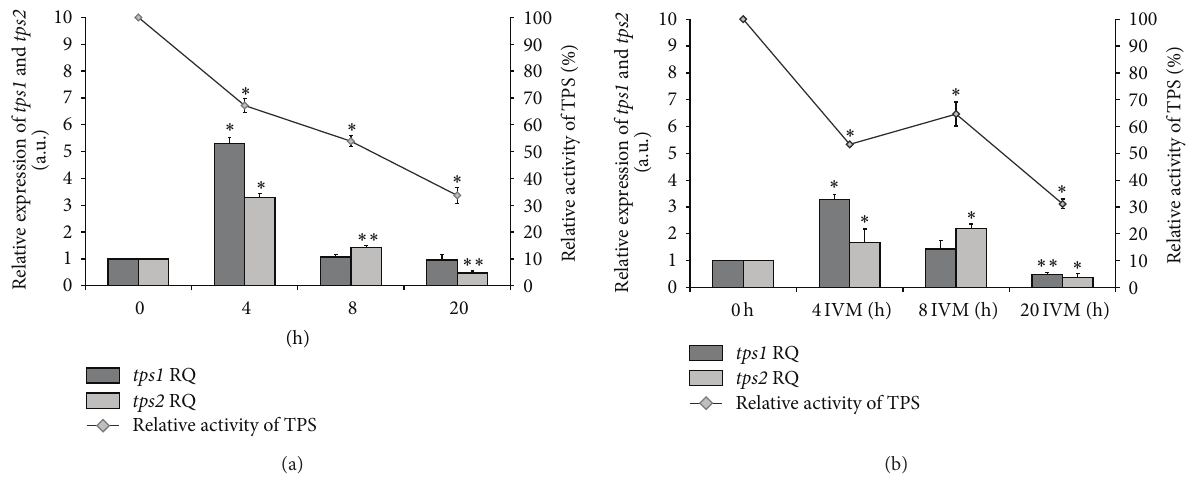
Figure 1: Relative activity of trehalose-6-phosphate synthase (TPS) and its mRNA ( tps1 , tps2 genes) expression normalized to the endogenous reference gapdh (glyceraldehyde-3-phosphate dehydrogenase) gene and relative to the expression at time zero (start group). IVM: ivermectin; RQ:relativequantification;(a)controlgroup;(b)IVM-group; ∗ significantchangeat 𝑃 < 0.01 and ∗∗ significantchangeat 𝑃 < 0.05 withrespect to the start group.